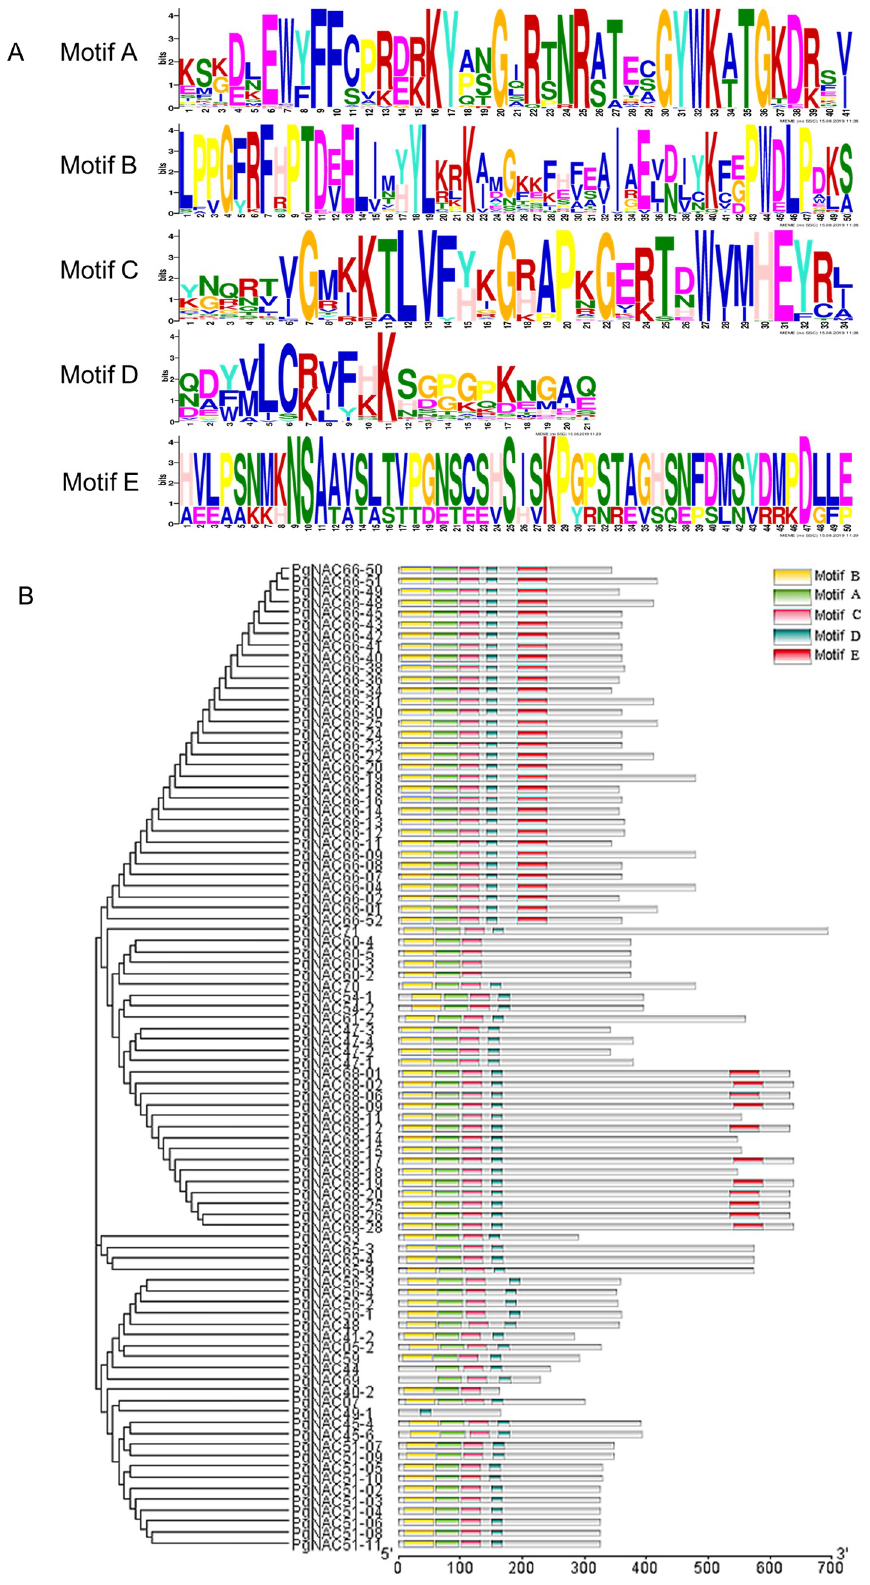
Fig 1. The conserved motifs (A) and their distributions (B) in PgNAC putative proteins. https://doi.org/10.1371/journal.pone.0234423.g001 PLOS ONE | https://doi.org/10.1371/journal.pone.0234423 June 11,